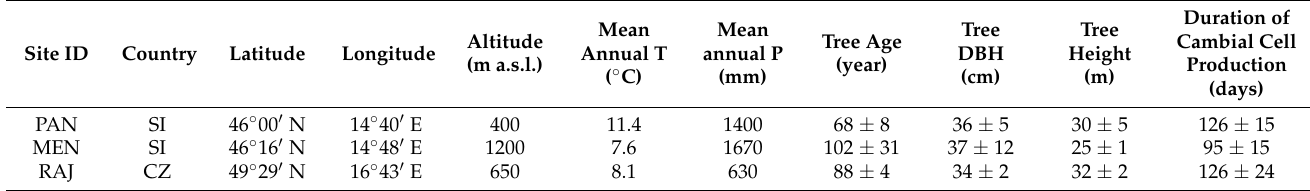
Table 1. Study site and characteristics of Picea abies trees. Temperature (T) and precipitation (P) data are for the period 1901–2011. DBH—diameter at breast